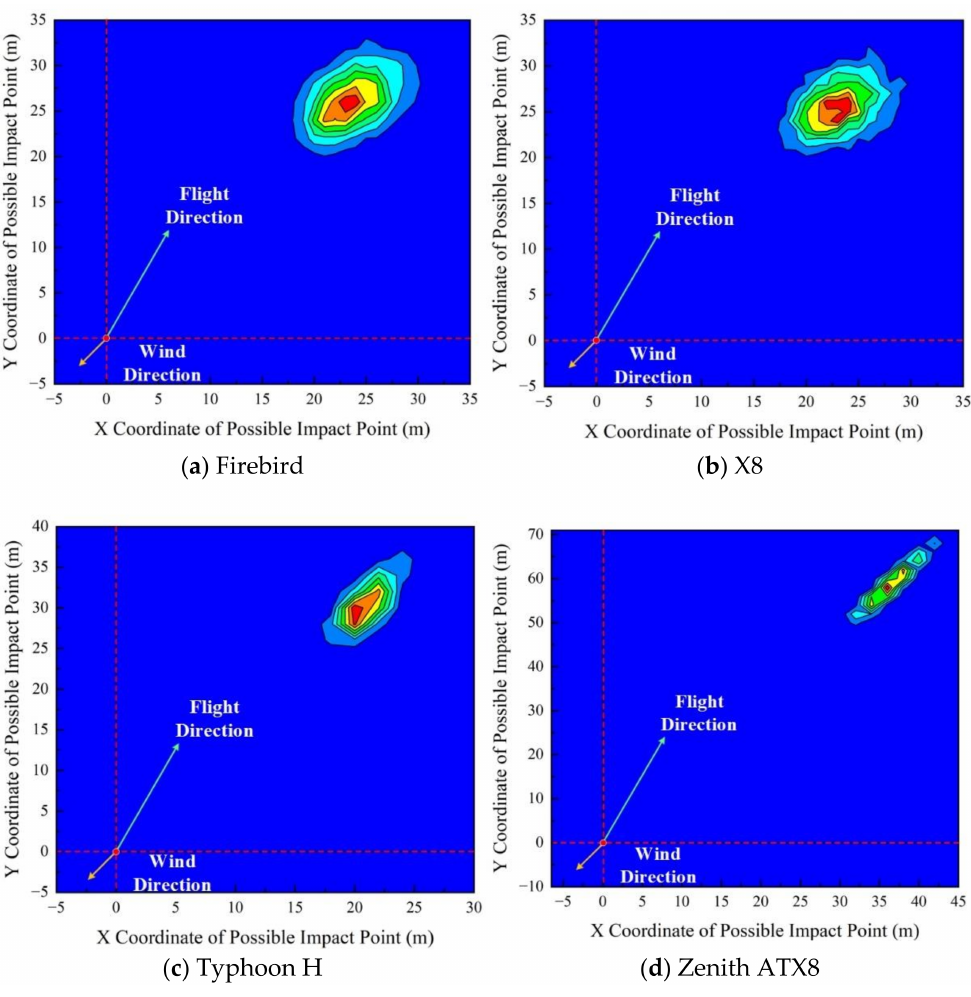
Figure 9. Possible ground impact positions with light